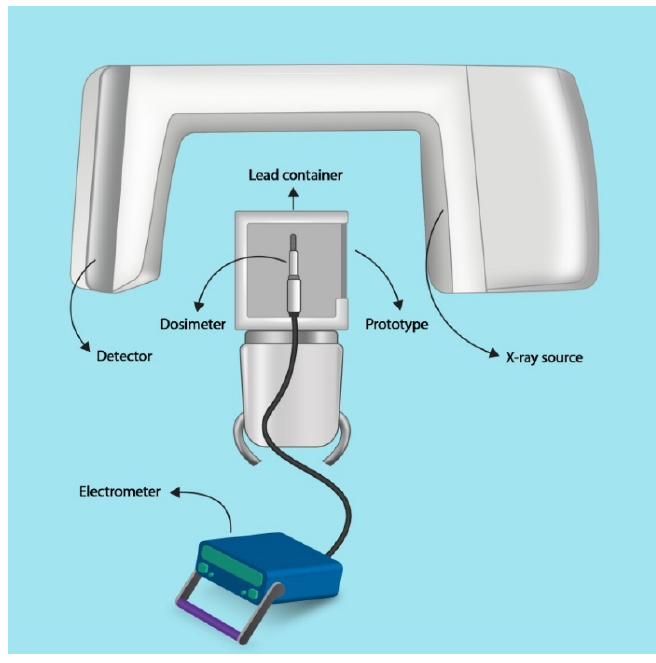
Figure 2. Schematic demonstration of the setup of the experiments.